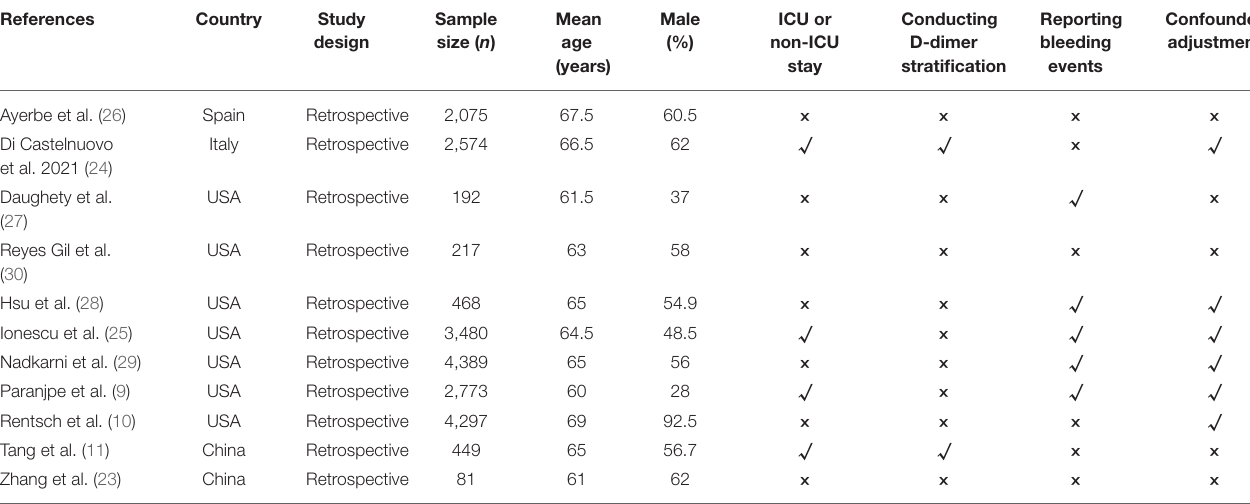
TABLE 1 | The detailed characteristics of each